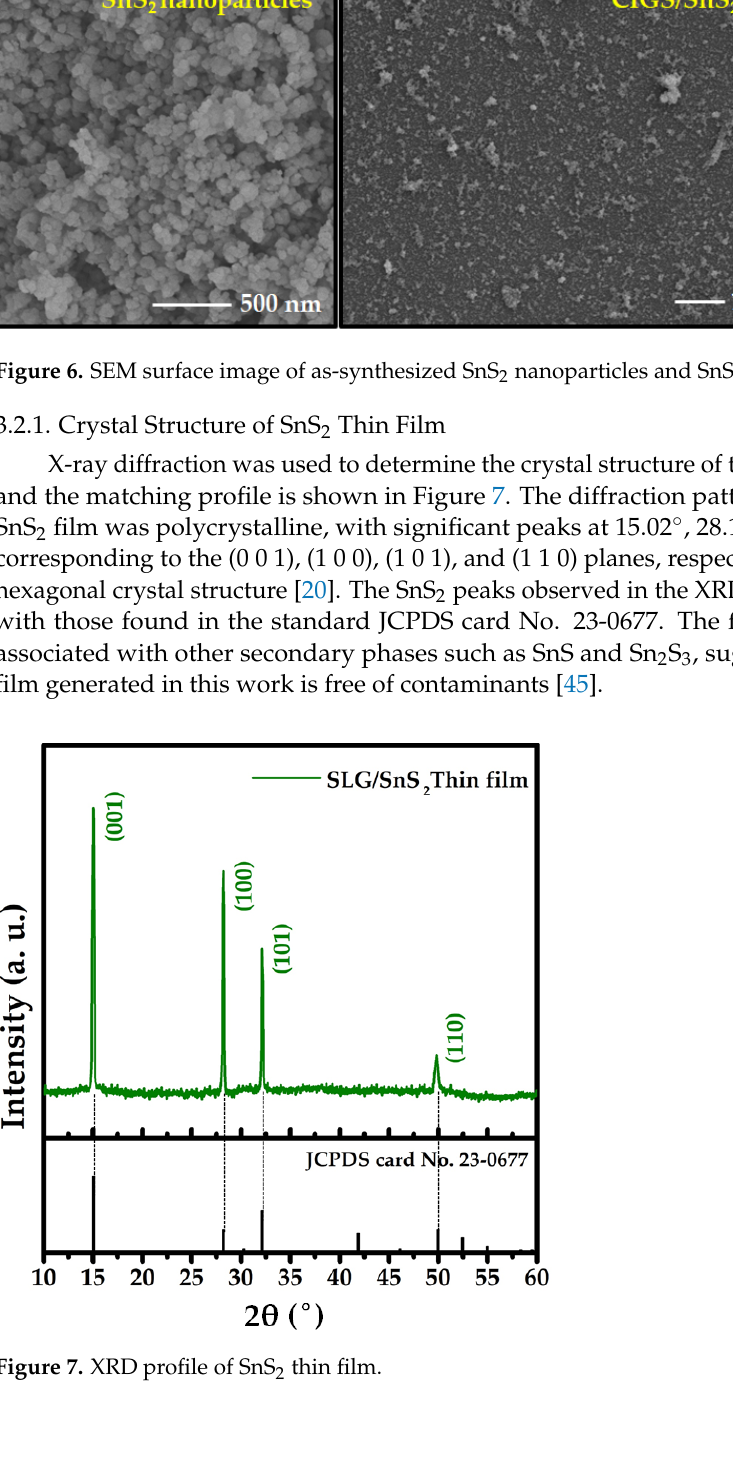
2 nanoparticles and SnS 2 thin film.